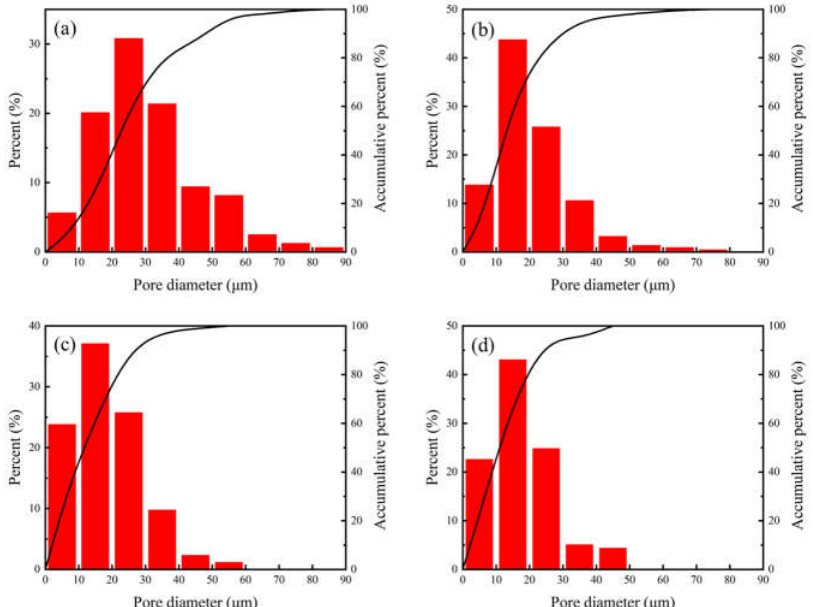
Figure 3. The relation between pore size distribution of sintered specimen with sintering temperature: ( a ) 950 °C; ( b ) 1000 °C; ( c ) 1050 °C; ( d ) 1100 °C.